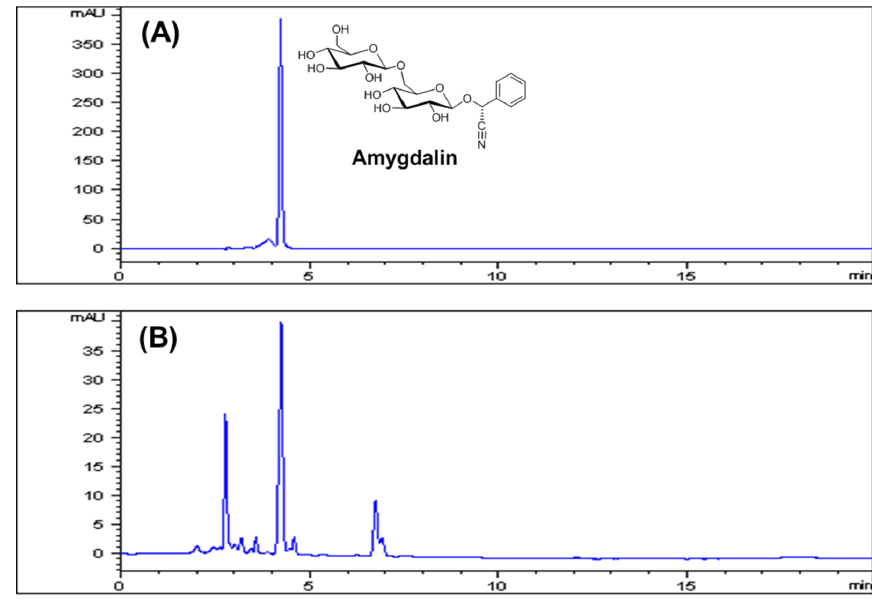
Figure 1. HPLC chromatographs of an amygdalin standard ( A ) and an extract of apricot kernel ( B ) with detection at 214 nm. The peak of amygdalin appeared at a retention time of 4.20 min. Table 1. Calibration data for an amygdalin standard.